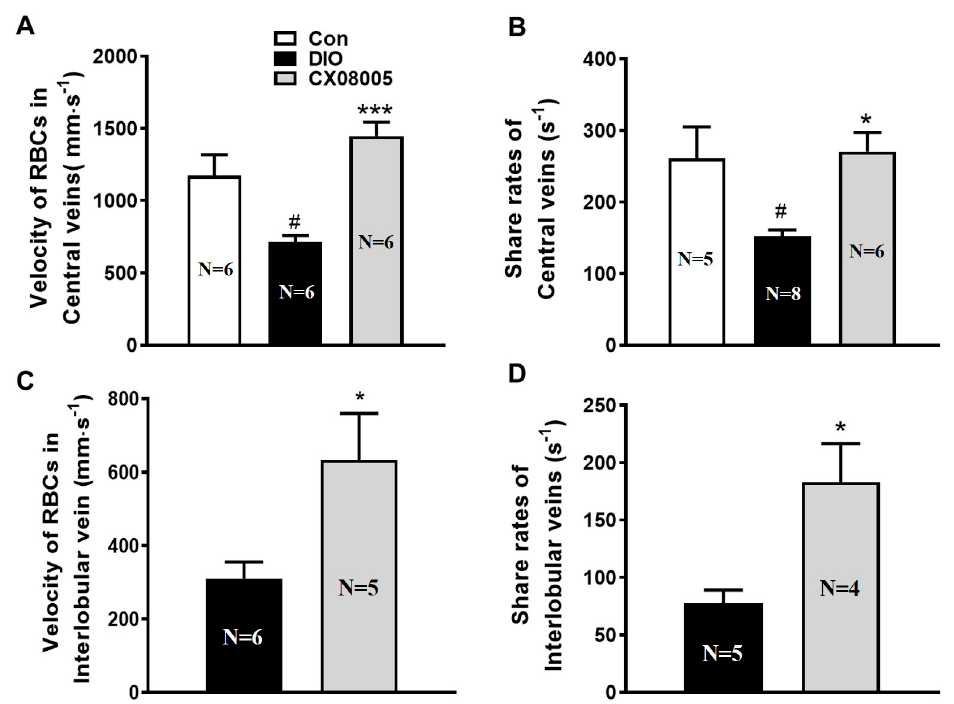
Figure 4. Effects of CX08005 on RBCs velocity and shear rates in DIO mice. ( A ) RBCs Velocity in central veins. ( B ) Shear rates of central veins. ( C ) RBCs Velocity in interlobular veins. ( D ) Shear rates of interlobular veins. Data are shown as means ± SEM. N = 4 − 8. # p < 0.05 vs. Con; * p < 0.05, *** p < 0.001 vs. DIO mice.